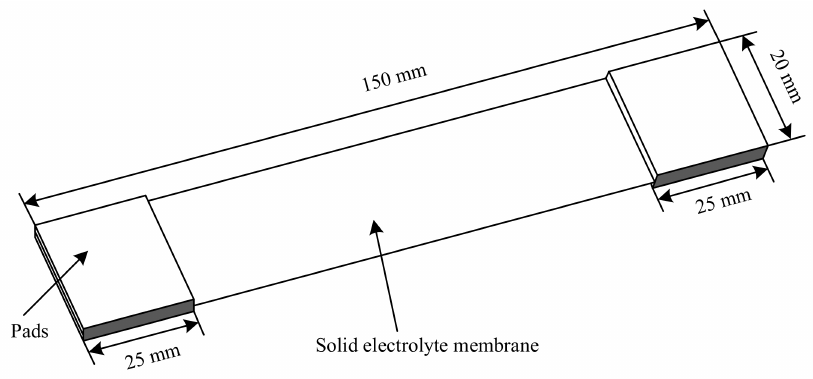
Figure 10. Sample of the electrolyte for the tensile